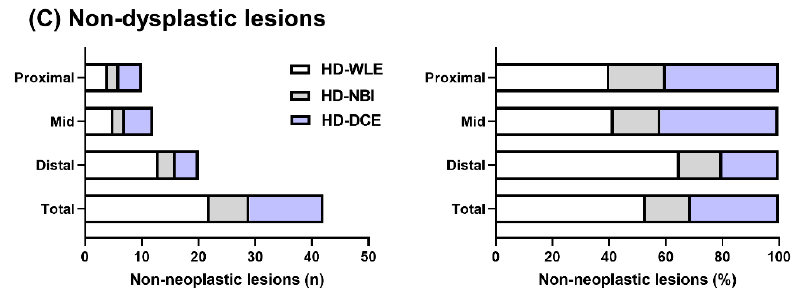
Figure 2. Number and proportion of dysplastic lesions, sessile serrated adenomas/polyps, and nondysplastic lesions detected by high-definition white-light endoscopy (HD-WLE), high-definition narrow-band imaging (HD-NBI), and high-definition dye spray chromoendoscopy (HD-DCE). ( A ) Colitis-associated dysplasia, ( B ) sessile serrated adenomas/polyps, and ( C ) non-dysplastic lesions. HD-WLE, high-definition white-light endoscopy; HD-NBI, high-definition narrow-band imaging; HD-DCE, high-definition dye spray chromoendoscopy. The total number of detected SSAs/Ps was 13, of which two SSA/Ps (15.4%) were located in the proximal colon, three (23.1%) were in the mid-colon, and eight (61.5%) were in the distal colon (Figure 2B). Among these 13 SSAs/Ps, five lesions (38.5%) were detected by HD-WLE (Figure 3A), one lesion was detected by HD-NBI (Figure 3B), and seven SSAs/Ps were detected by HD-DCE (Figure 3C). The incremental detection rates for dys- plasia and SSAs/Ps by NBI were 0% (95% CI: 0%–56.2%) and 7.7% (95% CI: 1.4%–33.3%), respectively. The incremental detection rates for dysplasia and SSAs/Ps by DCE were 0% (95% CI: 0%–56.2%) and 53.9% (95% CI: 29.1%–76.8%), respectively.